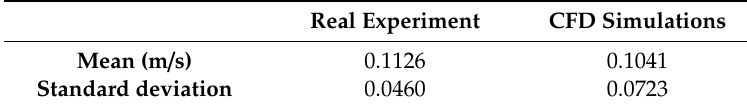
Table 3. Model errors considering all measuring points.